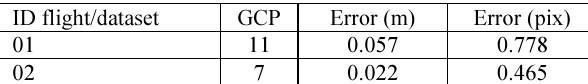
Table 4: Residual error of GCPs estimated positions by PhotoScan